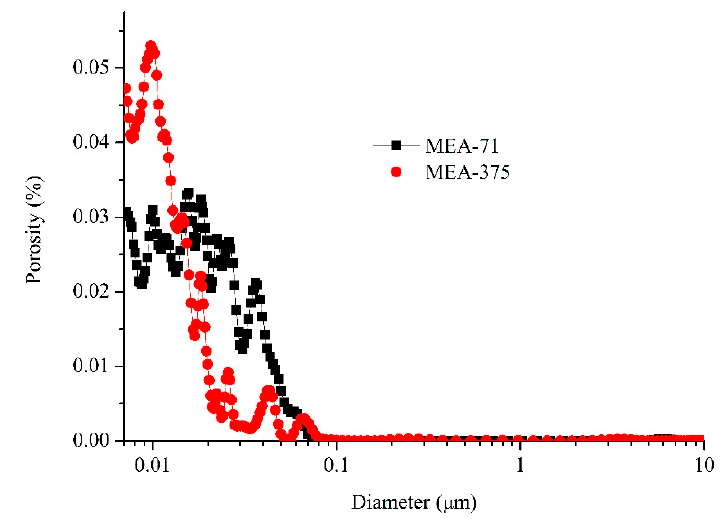
Figure 9. Pore size distribution of compacted MEA-71 and compacted MEA-375 cured in water at 40 °C for 3 days.